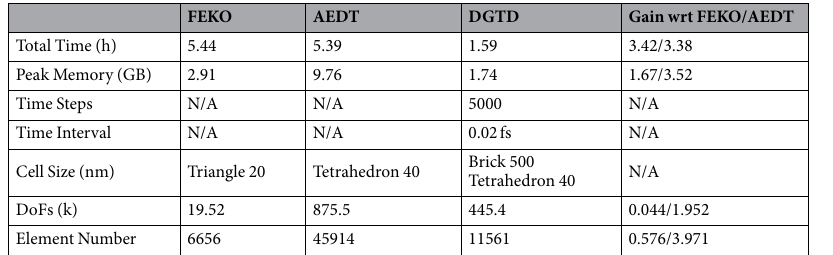
Table 3. Computational overhead comparison for the nanoloop coupling case between the DGTD method, AEDT and